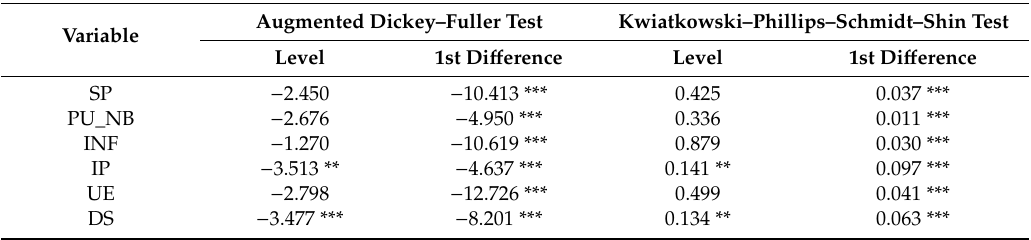
Table 2. Unit-root